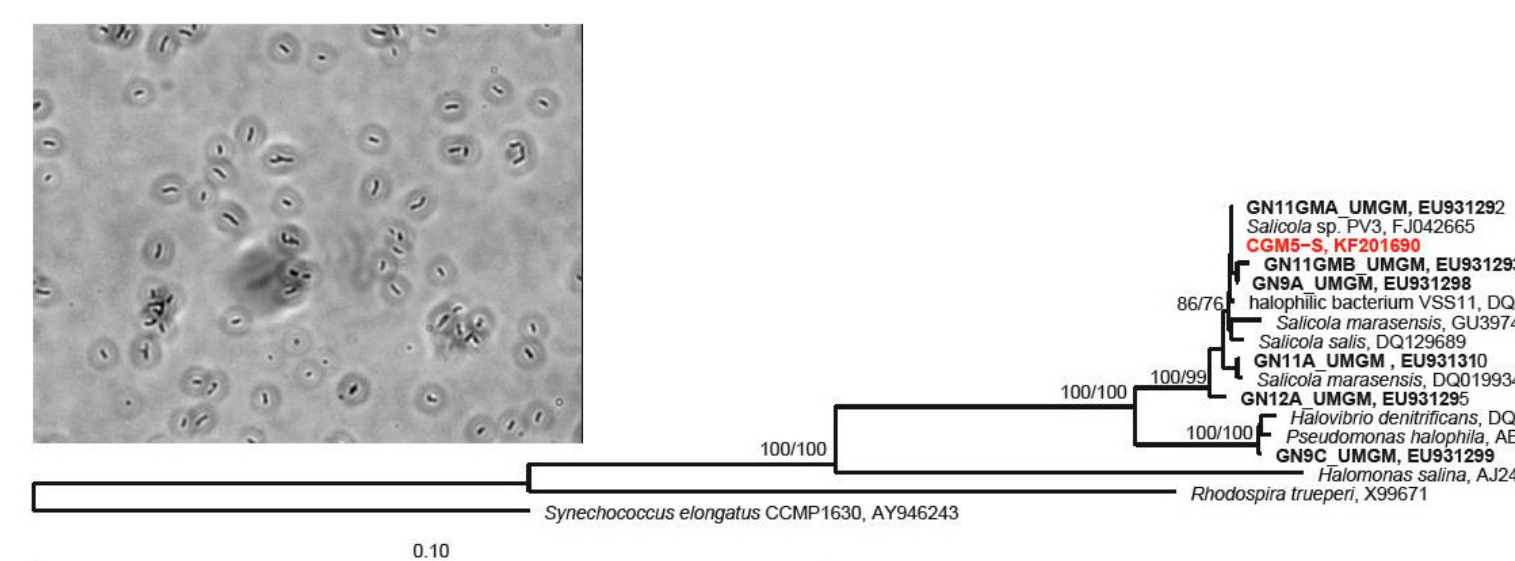
Figure 1. Neighbor-joining dendrogram depicting relationship of the CGM5-S host 16S rRNA gene sequence (red) with closely related sequences, and a photomicrograph of CGM5-S (inset). Guerrero Negro, Baja CA S., MX ESSA saltern strains have a GN prefix and are in bold. Numbers at nodes represent bootstrap confidence values for neighbor-joining / parsimony trees expressed as percentages from 1000 pseudoreplicates each. The Alphaproteobacterium Rhodospira trueperi and the cyanobacterium, Synechococcus elongatus , were used as outgroups.